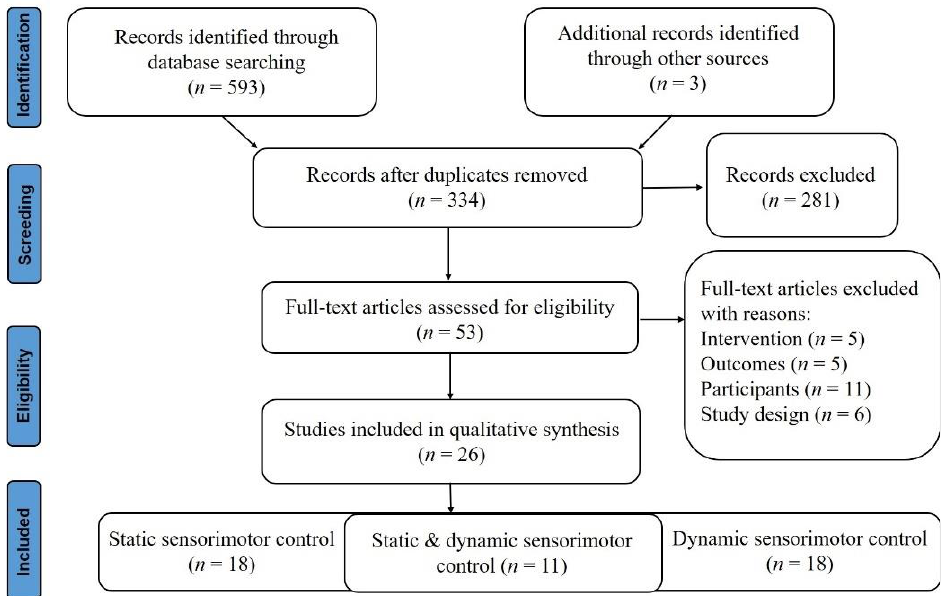
Figure 2. PRISMA summary of the study selection process.